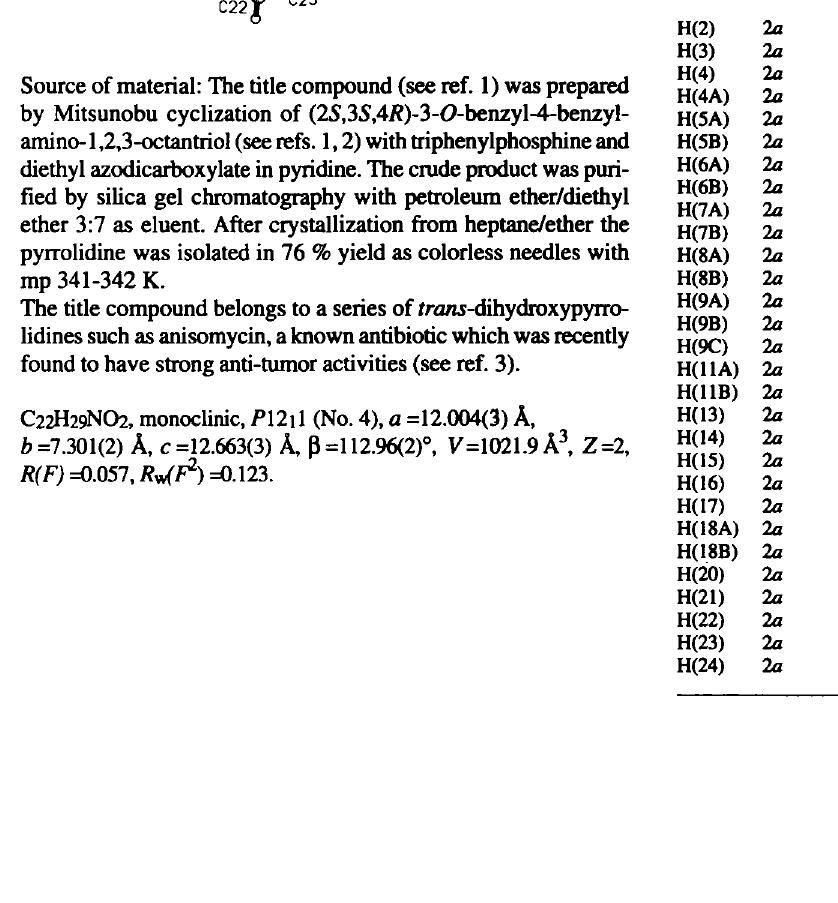
Table 2. Final atomic coordinates and displacement parameters (in A 2